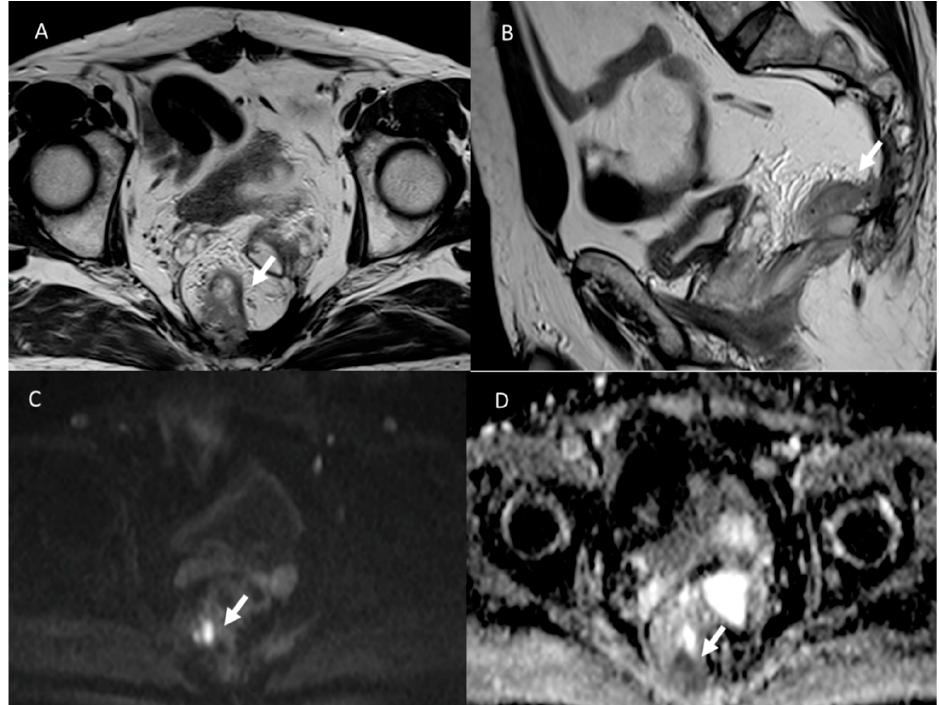
Figure 4. T2-W in sagittal plane ( A ) and T1-W post-contrast in sagittal plane ( B ) sequences of MRI assessment of post-surgical anastomotic leak. Arrows show a loss of continuity of the intestinal wall at the anastomosis site, with communication between the intra- and extra-luminal compartments. In DWI sequences ( C : b800s/mm 2 and D : ADC map), the lesion shows restricted